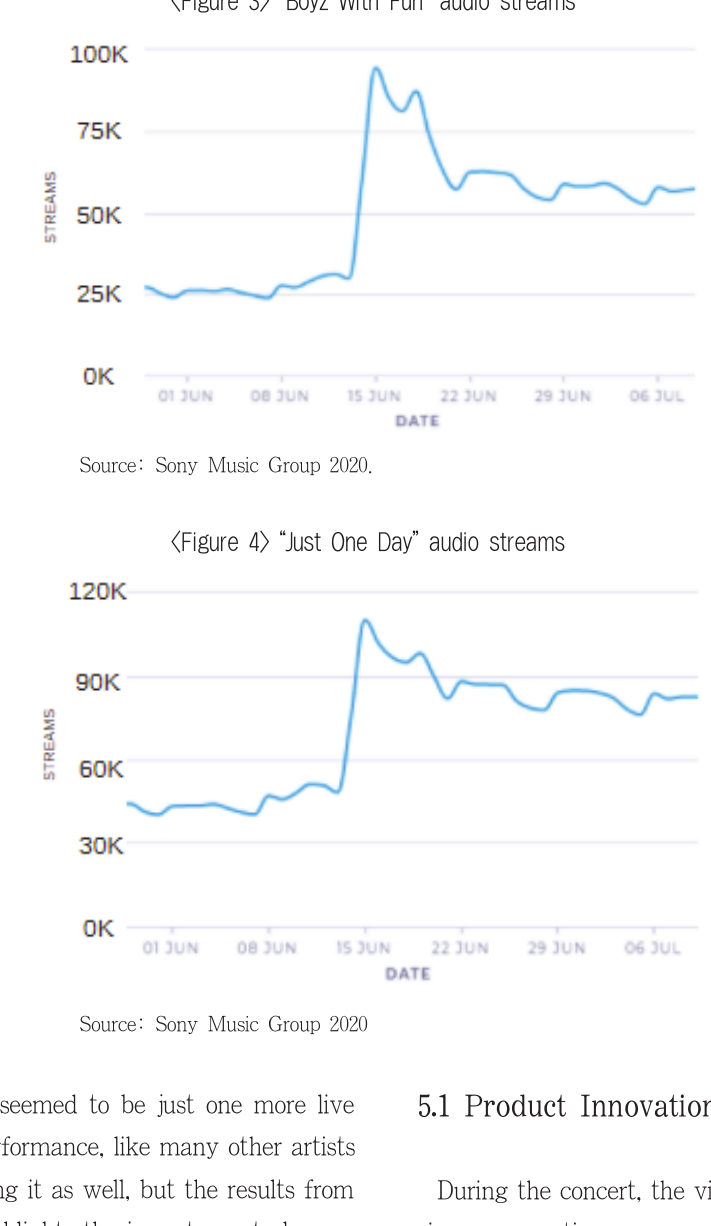
<Figure 3> “Boyz With Fun” audio streams